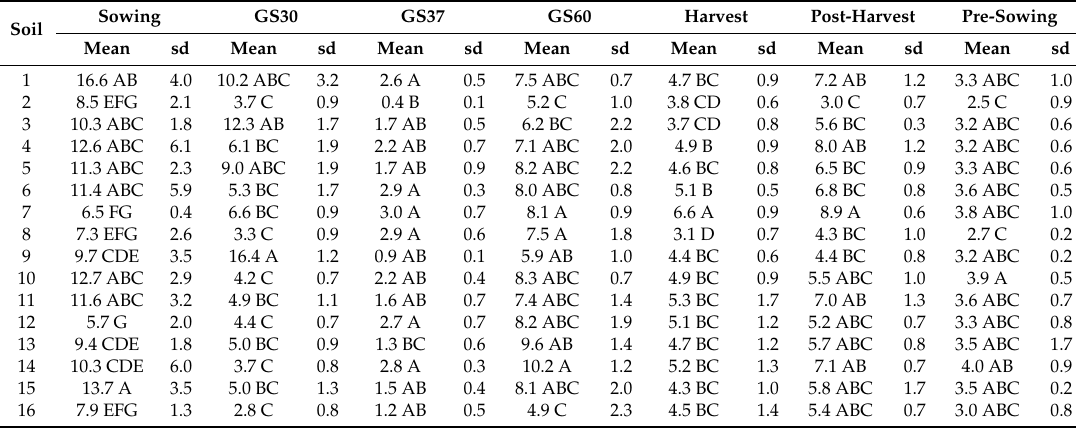
Table 2. Soil mineral nitrogen (N min ; mg kg − 1 ) evolution in 16 soils from Araba throughout the wheat growing season in a greenhouse experiment. Different letters represent significant differences ( p ≤ 0.05) among soils for each growing stage: sowing, stem elongation (GS30), leaf flag emergence (GS37), flowering (GS60), harvest, post-harvest, and